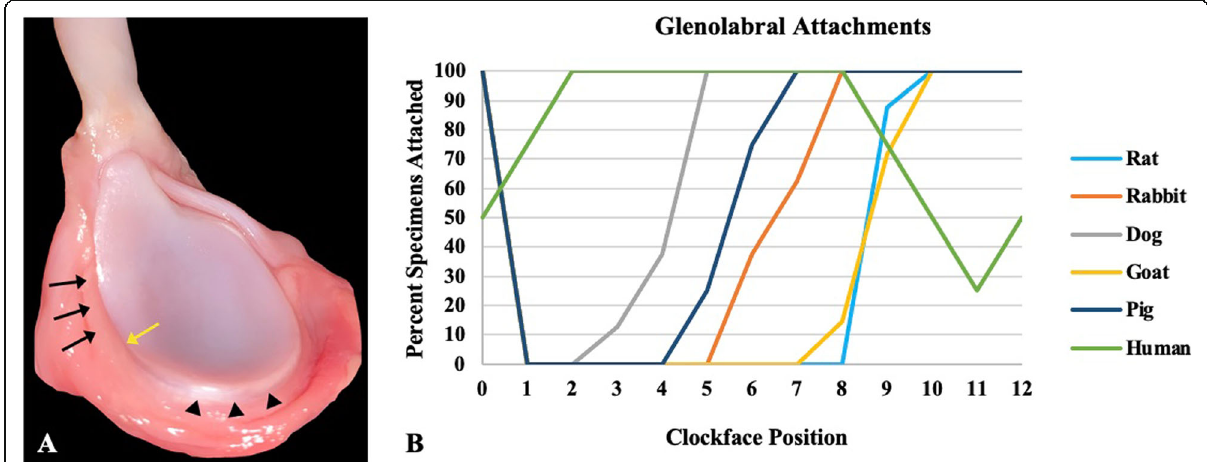
Fig. 3 A Delineation of continuous and recessed capsulolabral complex from the articular glenoid surface. Black arrows indicate continuous complex; arrowheads indicate recessed complex; yellow arrow indicates transition point between continuous and recessed complex. B Percent of specimens (by species) in which the capsulolabral complex was continuous with the glenoid articular